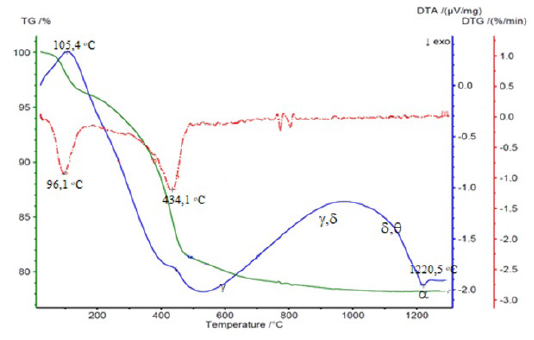
Figure 2. DTA and TG analysis of sample